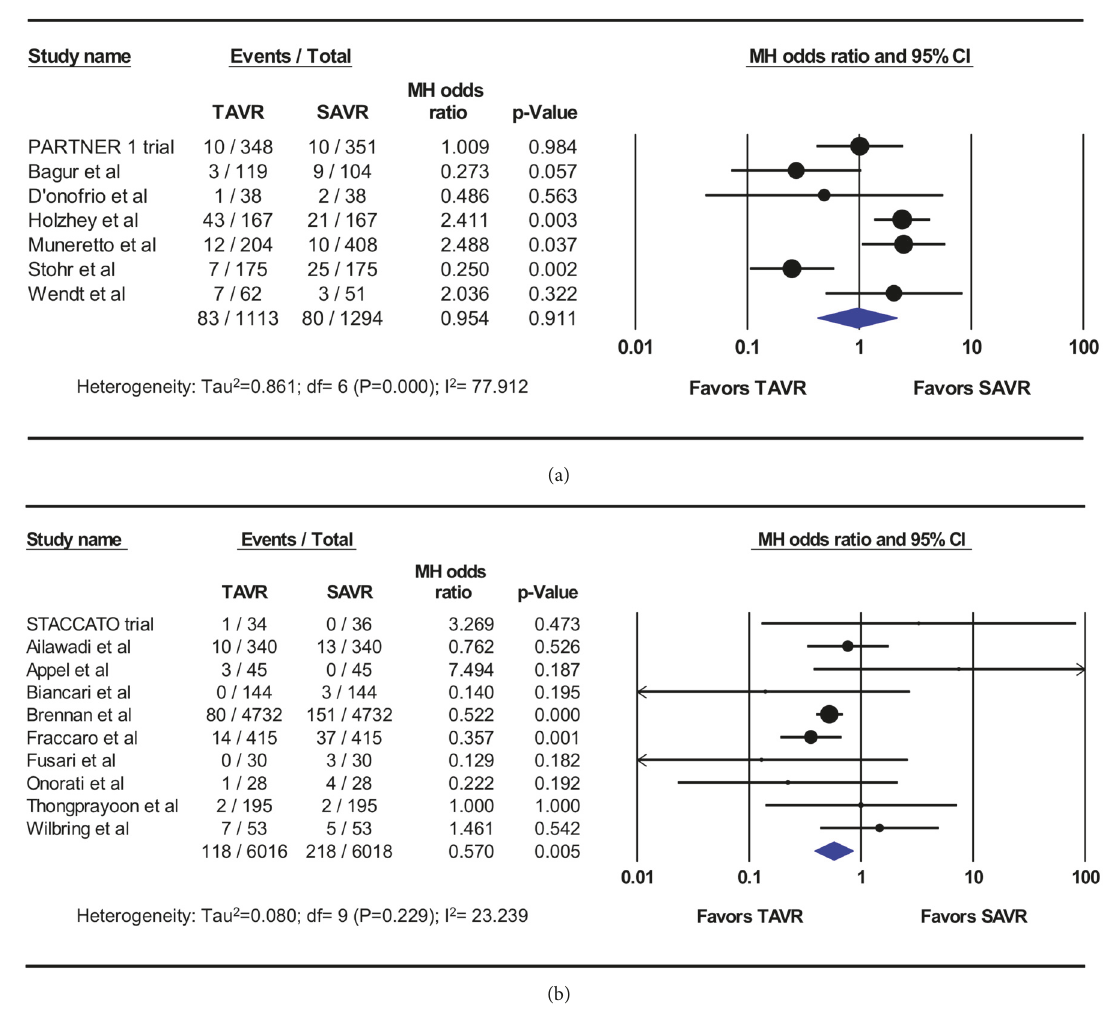
Figure 6: Pooled effect estimates for 30-day renal replacement therapy according to the type of aortic valve replacement procedure and surgical risk. TAVR: transcatheter aortic valve replacement, SAVR: surgical aortic valve